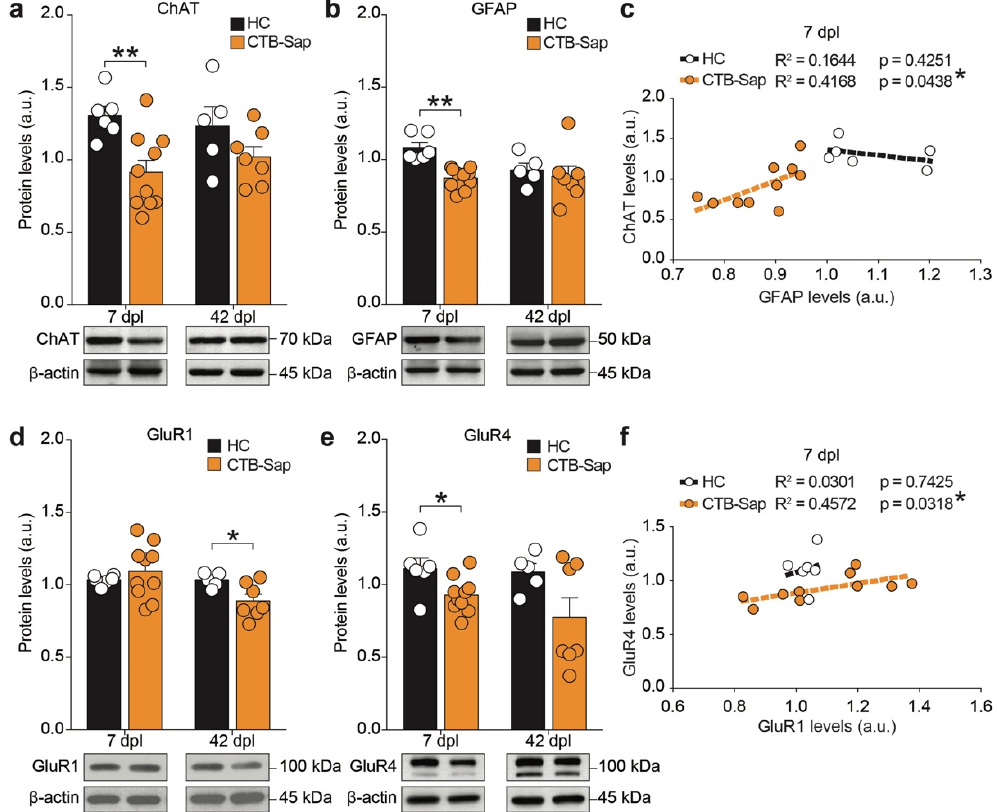
Figure 5. Spinal plasticity in CTB-Sap lesioned mice involves AMPA receptor subunits, GluR1 and GluR4. ( a , b ) Quantification and representative blots of ChAT ( a ) and GFAP ( b ) protein levels at 7 and 42 dpl in HC and CTB-Sap lesioned mice; data are shown as mean ± SEM; each dot represents a single subject ( n = 6 HC, and n = 10 CTB-Sap mice); ** p -value < 0.01, unpaired t -test; ( c ) linear regression analysis of ChAT and GFAP levels in HC and CTB-Sap mice; * p -value < 0.05; ( d , e ) quantification and representative blots of GluR1 ( d ) and GluR4 ( e ) protein levels at 7 and 42 dpl in HC and CTB-Sap lesioned mice; data are shown as mean ± SEM; each dot represents a single subject ( n = 6 HC, and n = 10 CTB-Sap mice); * p -value < 0.05, unpaired t -test; ( f ) linear regression analysis of GluR1 and GluR4 levels in HC and CTB-Sap mice; * p -value < 0.05.